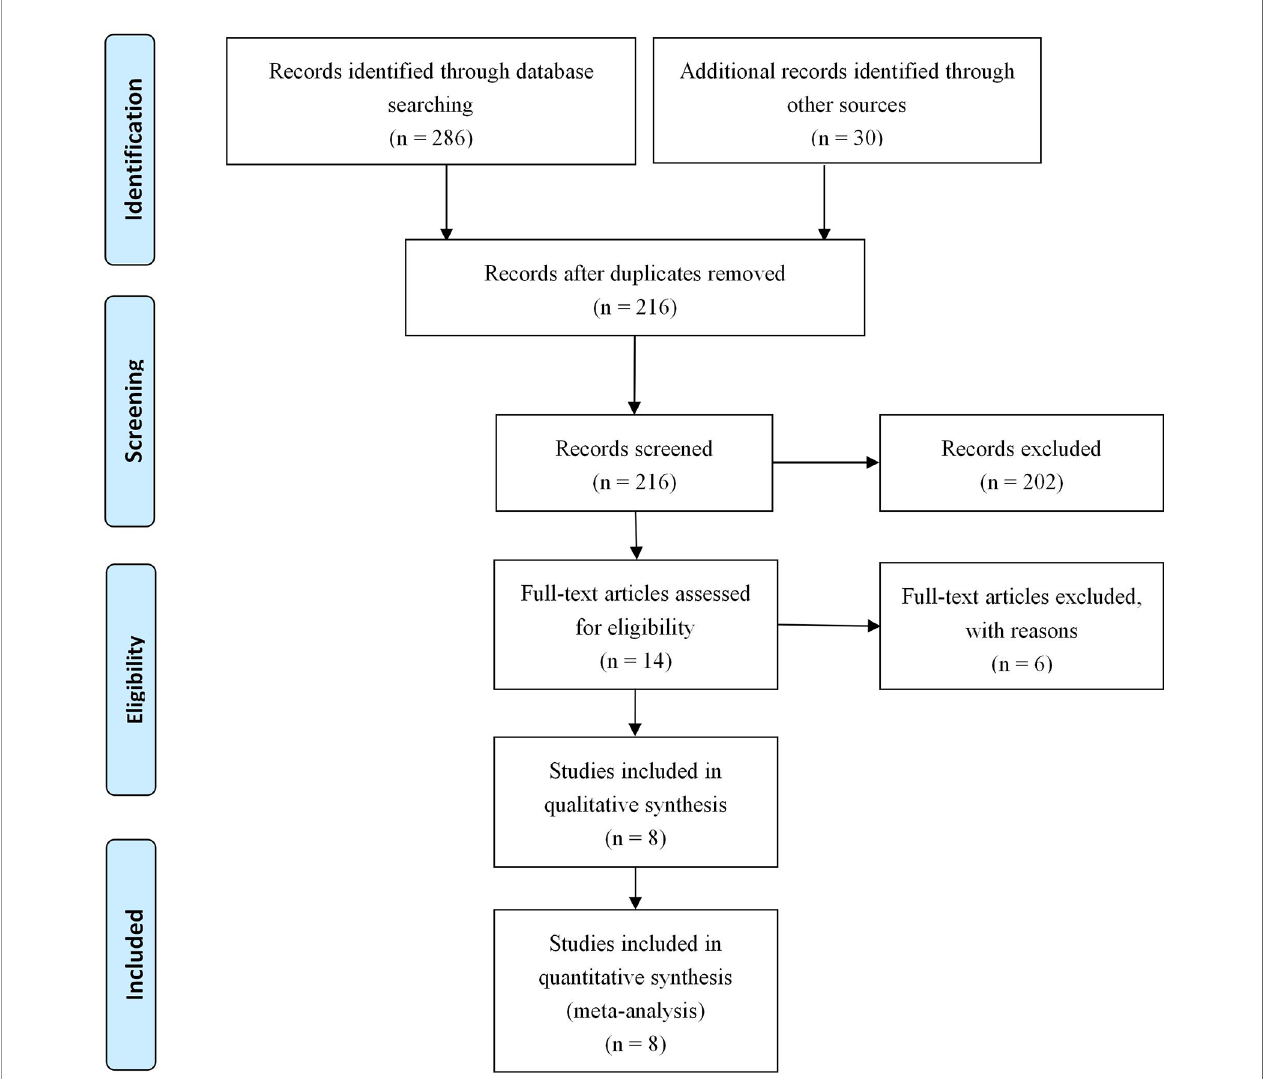
FIGURE 1 | PRISMA fl ow diagram of the